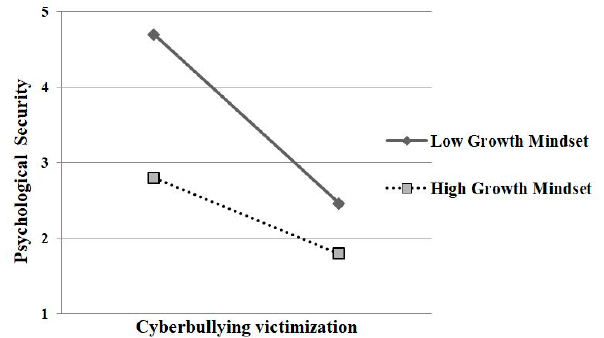
Figure 2. Growth mindset moderated the relationship between cyberbullying victimization and psychological security.